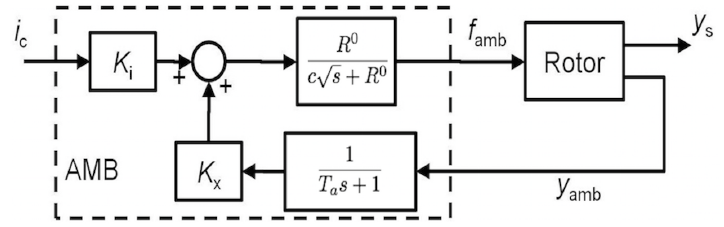
Figure 16. Thrust AMB system block diagram.